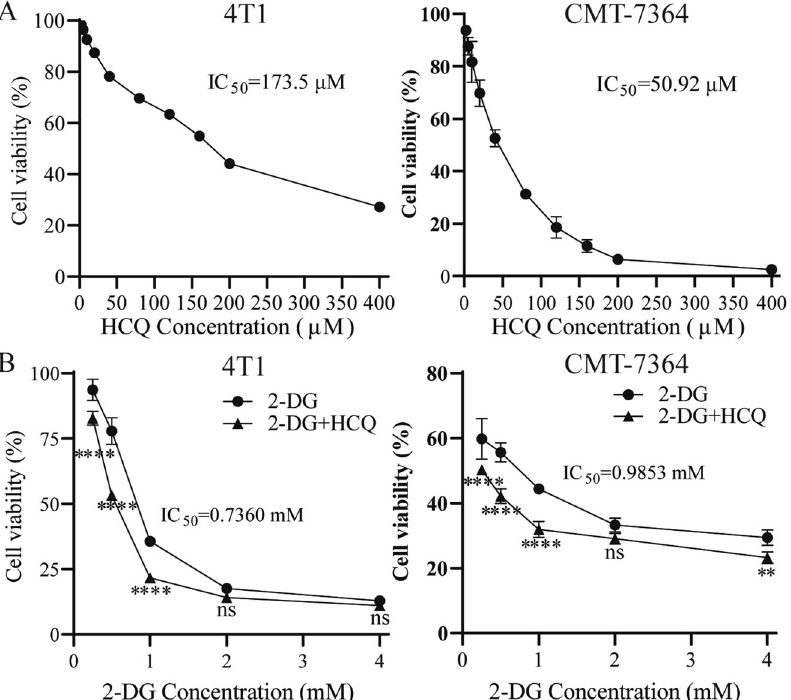
cell viability than 2-DG alone. n = 5 for each group. Data are presented as the means ± SD of three independent experiments. ** p < 0.01, **** p < 0.0001, ns = not signi fi cant ( p ≥